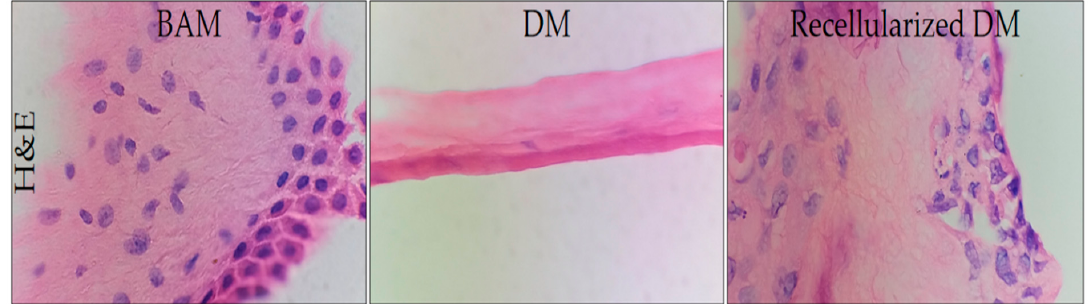
Figure 5. Microphotographs for BAM ( left ), DM ( middle ), and recellularized DM ( right ) obtained from the hematoxylin-eosin (H&E) assay (100×).